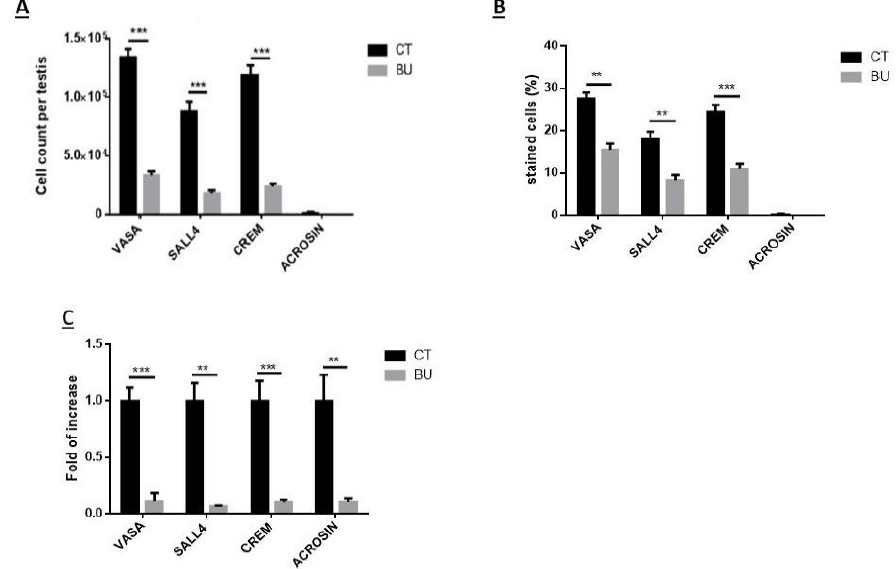
Figure 5. Effect of 10-day post busulfan (BU) treatment on spermatogenic cell counts, percentages and expression: BU or DMASO (control, CT) were i.p injected, as described in Figure 1. Ten days after the injection, the testes were removed, seminiferous tubules were separated, and cells were enzymatically isolated from the seminiferous tubules. The premeiotic (CD9, VASA, and SALL4), meiotic (CREM, BOULE, and ACROSIN), and postmeiotic (ACROSIN) cells were identified by immunofluorescence staining using the antibodies specific for each marker (Figure 4B). The above identified spermatogenic cells were counted and calculated per testicle ( A ), and their percentage was evaluated ( B ). Their expression was analyzed by qPCR analysis (fold of increase compared to control) ( C ). ×40 light microscope magnification (100 µm scale). ** p < 0.01 and *** p < 0.001